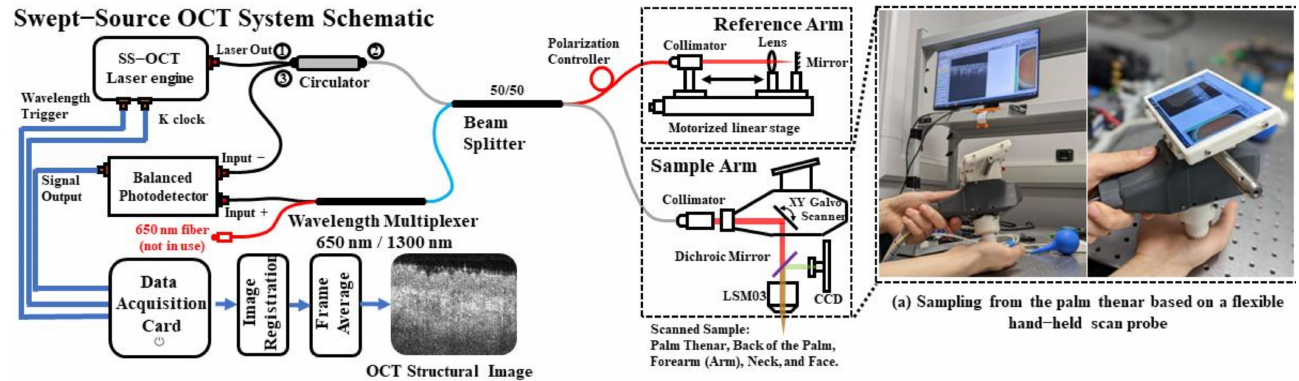
Figure 2. The system schematic of the swept-source (SS) OCT system in this study. The data acquisition card used in the personal computer (PC) is an ATS9371 from AlazarTech TM , and the sample lens in the system is an LSM03 from Thorlabs with a 35 mm focus length. ( a ) A demonstration of the data acquisition with a flexible hand-held scan probe, which is built-in in the SSOCT